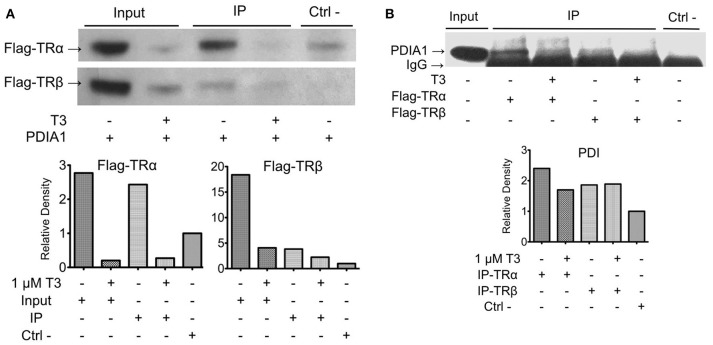
Co-immunoprecipitation of TR:PDIA1 in 293T cells shows the interaction for both isoforms with or without T3 presence. (A) Immunoprecipitation of PDIA1 followed by Western Blot anti-flag, revealing Co-IP of PDIA1 and flag-TRs. The treatment with T3 (1 μM) decreases TR expression in 293T cell (input bands are thinner) reducing protein available to be immunoprecipitated. The interactions of TRs with PDIA1 were confirmed according to the quantification of bands (presented in the graphs below the WB). (B) Immunoprecipitation of flag tagged TRs (+ or –T3), and western blot anti-PDIA1. Control experiment WB anti-flag is presented in Supplementary Figure 2A, together with a confirmation experiment (Supplementary Figure 2B). Although WB shows strong IgG band, it is still possible to observe the presence of PDIA1 in all conditions, co-immunoprecipitated with both isoforms of TR. The quantification of bands are presented in graphs below WB, where all signals were normalized to the control signal (relative Density). 293T cell extracts without T3 and without transfection of flag-TRs were used on this experiment as negative control. Co-IP and WB experiments were performed more than once and here we show a representative image.